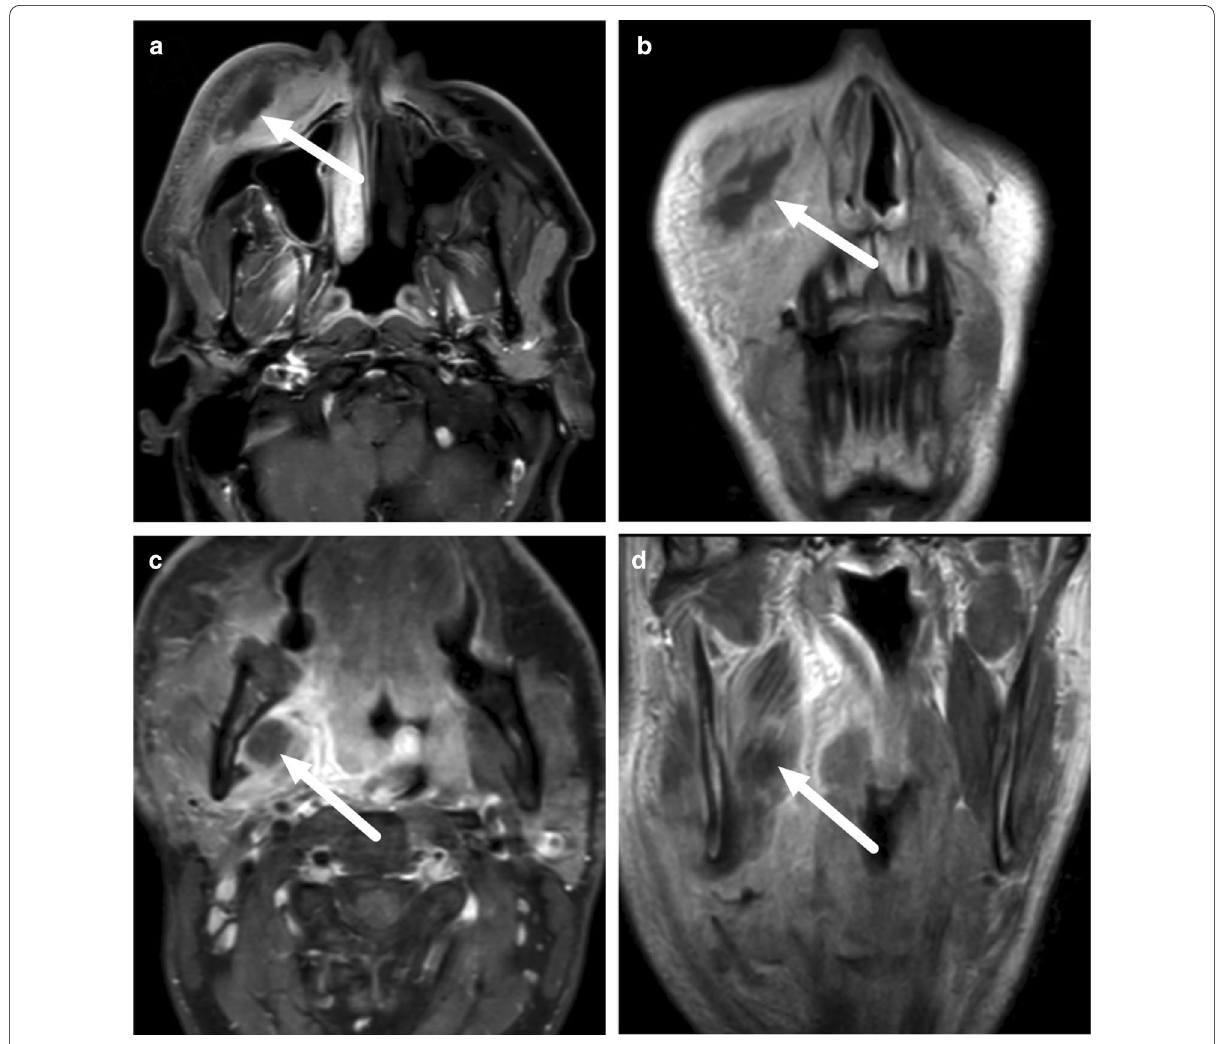
Fig. 18 Odontogenic maxillofacial infections in two patients ( a and b , c and d ). Axial fat-suppressed ( a , c ) and coronal ( b , d ) post-contrast T1-weighted images show buccal space ( a , b ) and masticator space ( c , d ) abscesses (arrows). Image modified from ref. [11]